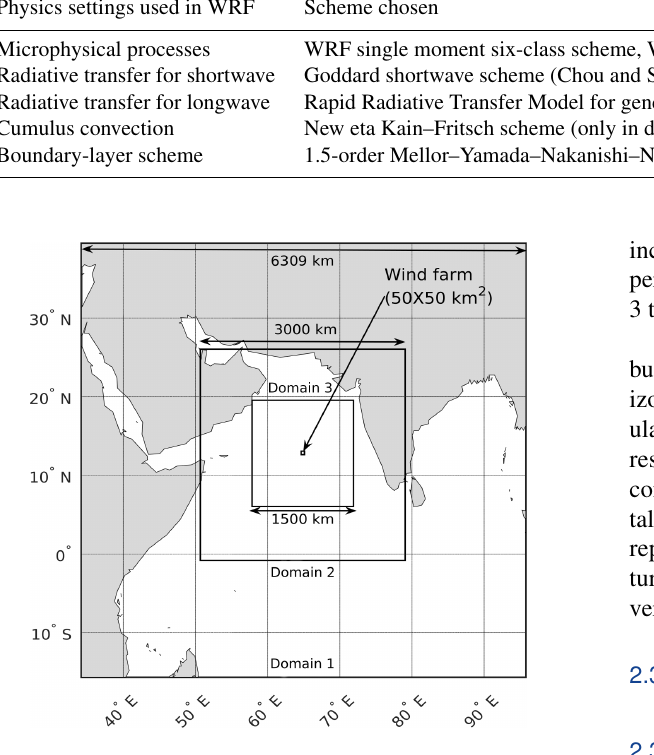
Figure 1. Model domain showing the three nested grids. The small rectangle in the center shows the wind